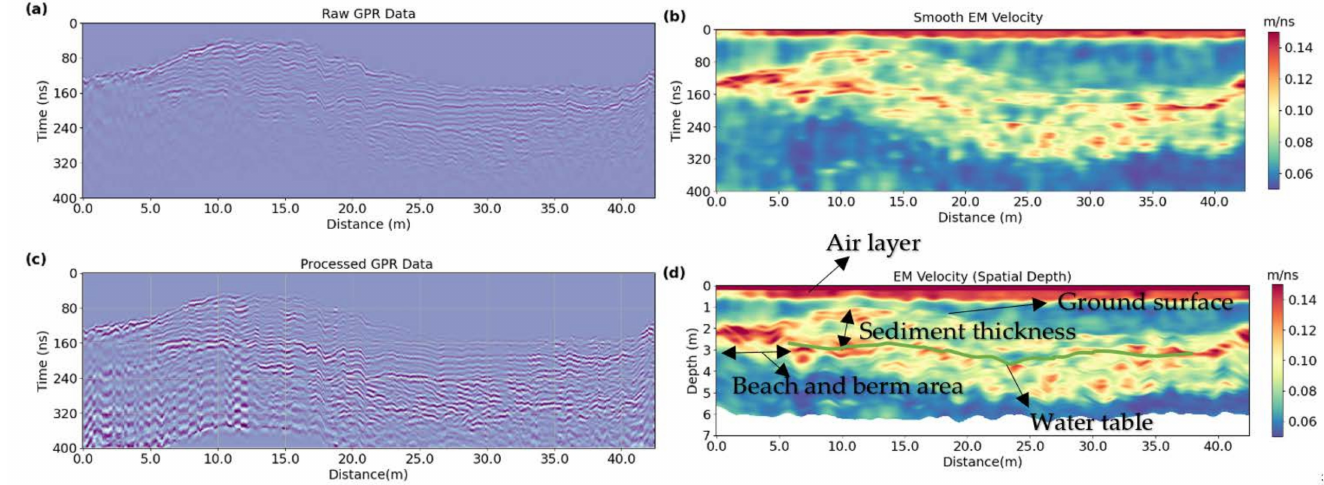
Figure 18. ( a ) Topographically corrected raw GPR data, ( b ) predicted velocity map in the time domain, ( c ) processed GPR data, and ( d ) velocity map in the depth